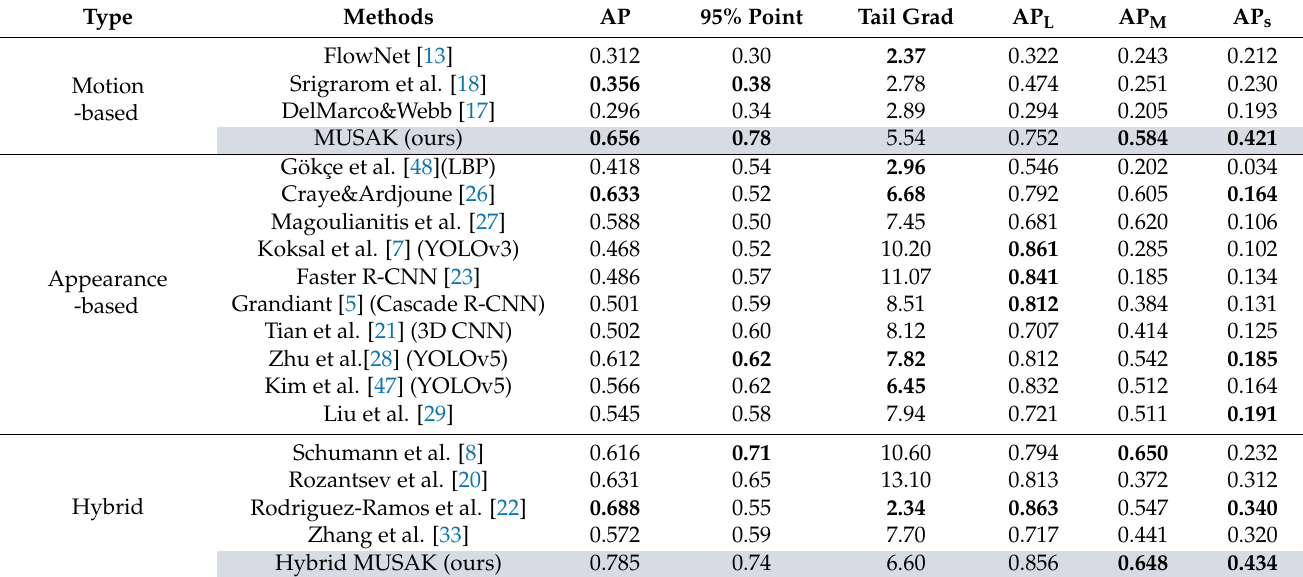
Table 4. Methods comparison by the